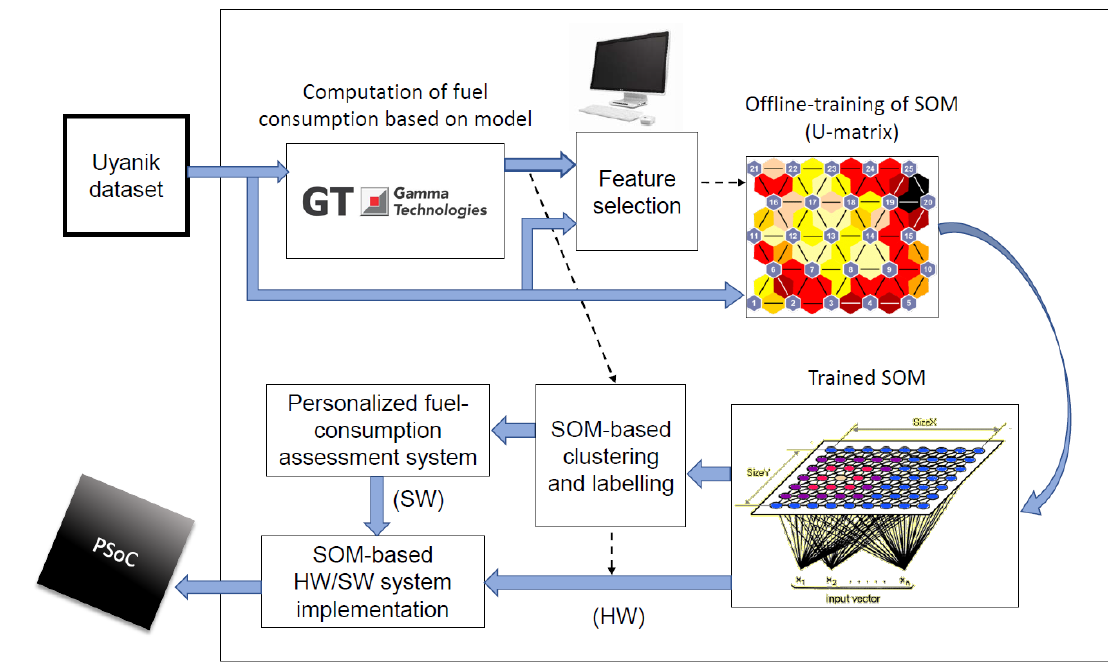
Figure 2. Offline sequence of tasks involved in the design and development of an self-organized map (SOM)-based intelligent system for fuel consumption assessment. The dotted arrows indicate that the simulated fuel consumption data are also used to label the SOM-based clustering for verification purposes and to elaborate the hardware (HW) implementation of the